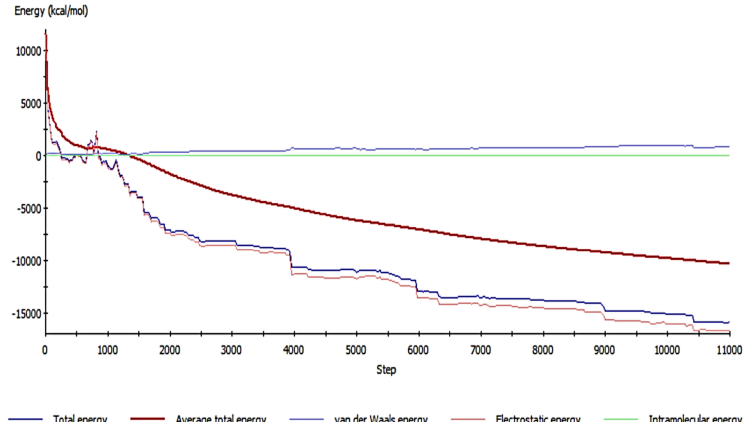
Figure 11. Variation in the silica structure’s energies during ions loadings.